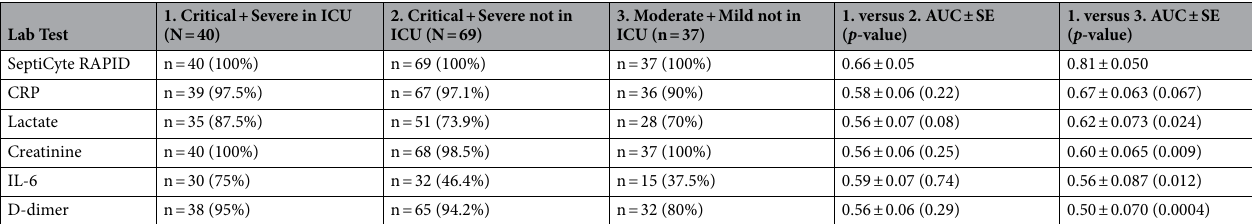
Table 3. Performance of SeptiCyte RAPID relative to other clinical laboratory tests. Critical + severe cases in ICU (n = 40) were compared to moderate + mild cases not in ICU (n = 37). Values in parentheses ( ) represent the % of patients in each clinical category for whom the relevant laboratory test results were available. There were some missing values as indicated by the percentages in the table. AUC values were compared to the SeptiCyte RAPID AUC with a bootstrap method as described in 23 , and p -values for the AUC comparisons are indicated.